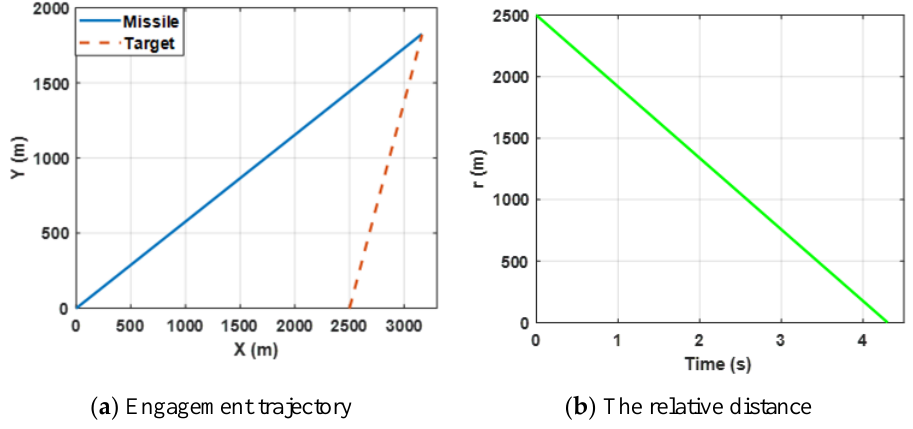
Figure 2. Engagement scenario for the proposed guidance strategy.